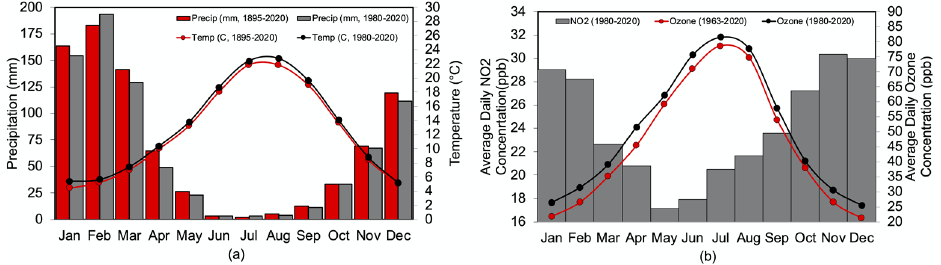
Figure 2. Climatology and pollution over the studied period ( a ) is the mean climatology over the study site calculated over the length of the time series (1895–2020) and calculated over the common period (1980–2020). Precipitation (1895–2020) given in red bars, precipitation (1980–2020) given in gray bars. Temperature (1895–2020) given in the red line, temperature (1980–2020) given in the black line. Data from PRISM, Spatial resolution 4km 2 , Lat: 34.25° N, Lon: 117.29° N [47]. ( b ) is the average daily concentrations of O 3 per month over the length of the time series (1963–2020) given in the red line and over the common period (1980–2020) given in the black line and NO 2 per month (1980–2020) given in the gray bars at the study site. Data from EPA AIRS [46].